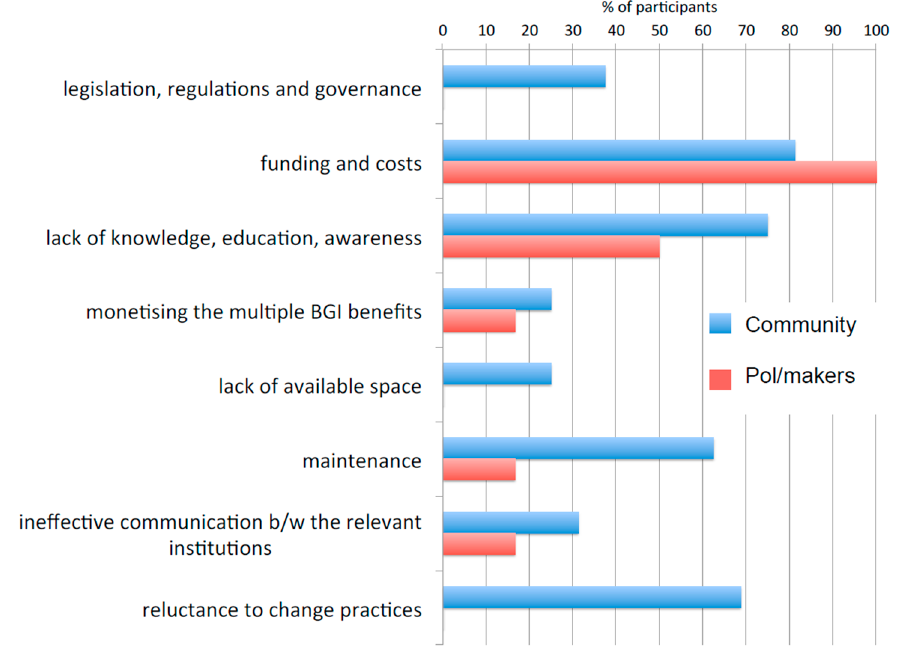
Figure 9. Comparison of community and policymaker views on BGI adoption challenges.